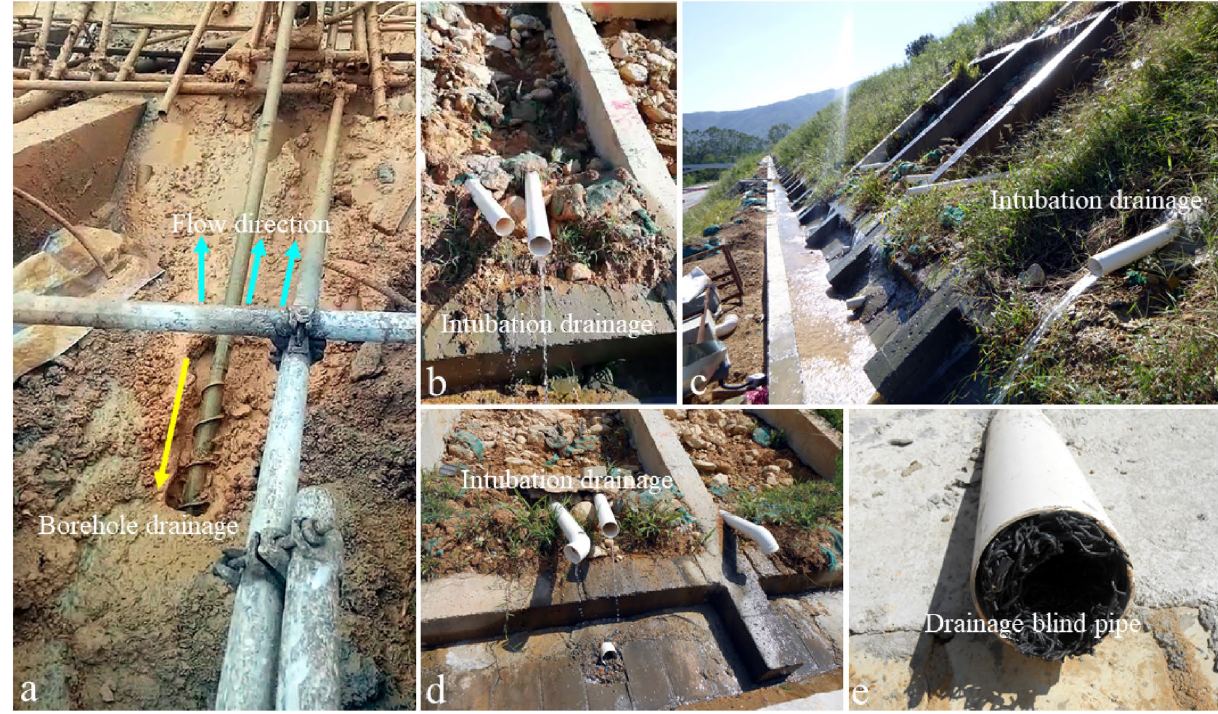
Figure 12. Drainage measures were taken to reduce landslide risk. ( a ) Borehole drainage (construction of deep horizontal drain hole); ( b–d ) slope insert tilted drainpipe; ( e ) buried drainage blind pipe.